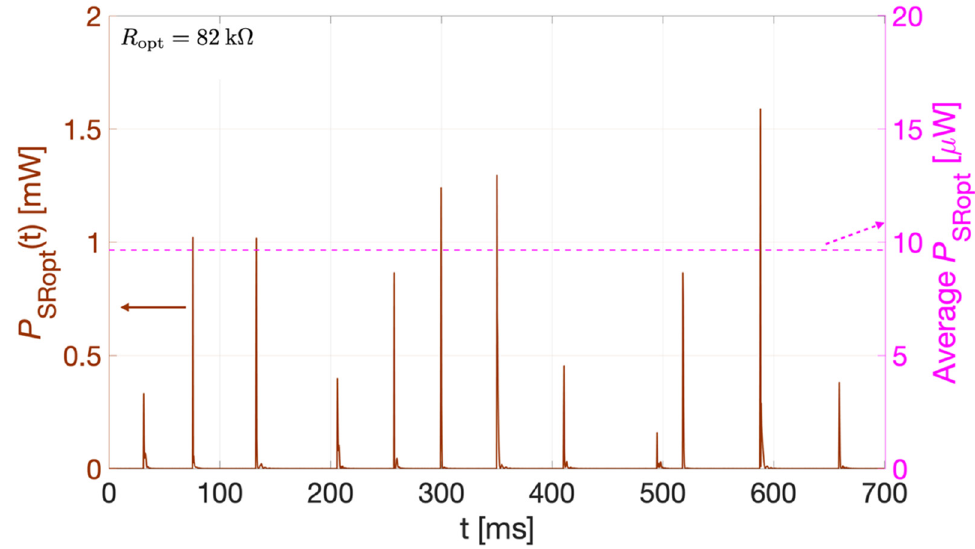
Figure 15. Sum of the instantaneous power P SRopt (t) (brown curve) and its average value (pink dotted line), obtained from the experimental results reported in Figure 14.